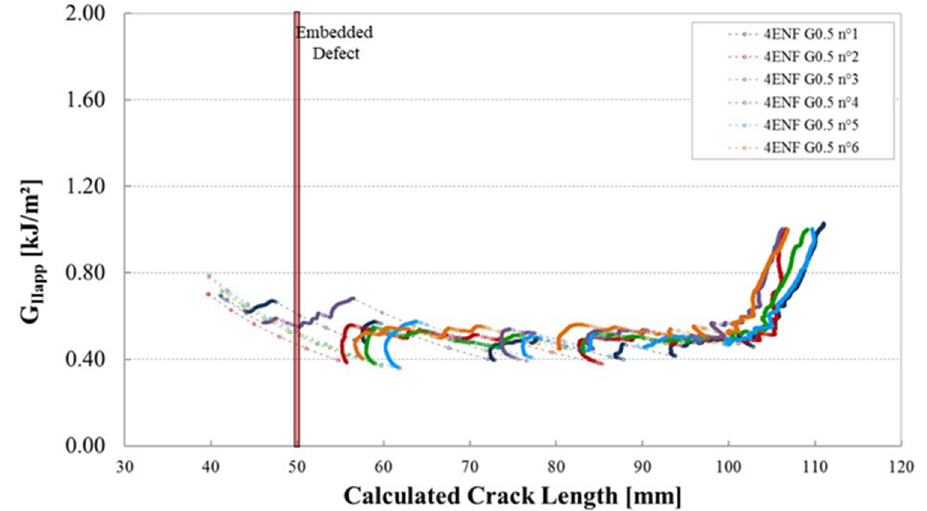
Figure 12. Mode II fracture energy as a function of the crack length for six 4ENF specimens containing a gap of 0.5 mm from a plate manufactured with caul plate (reference configuration considered without defects).